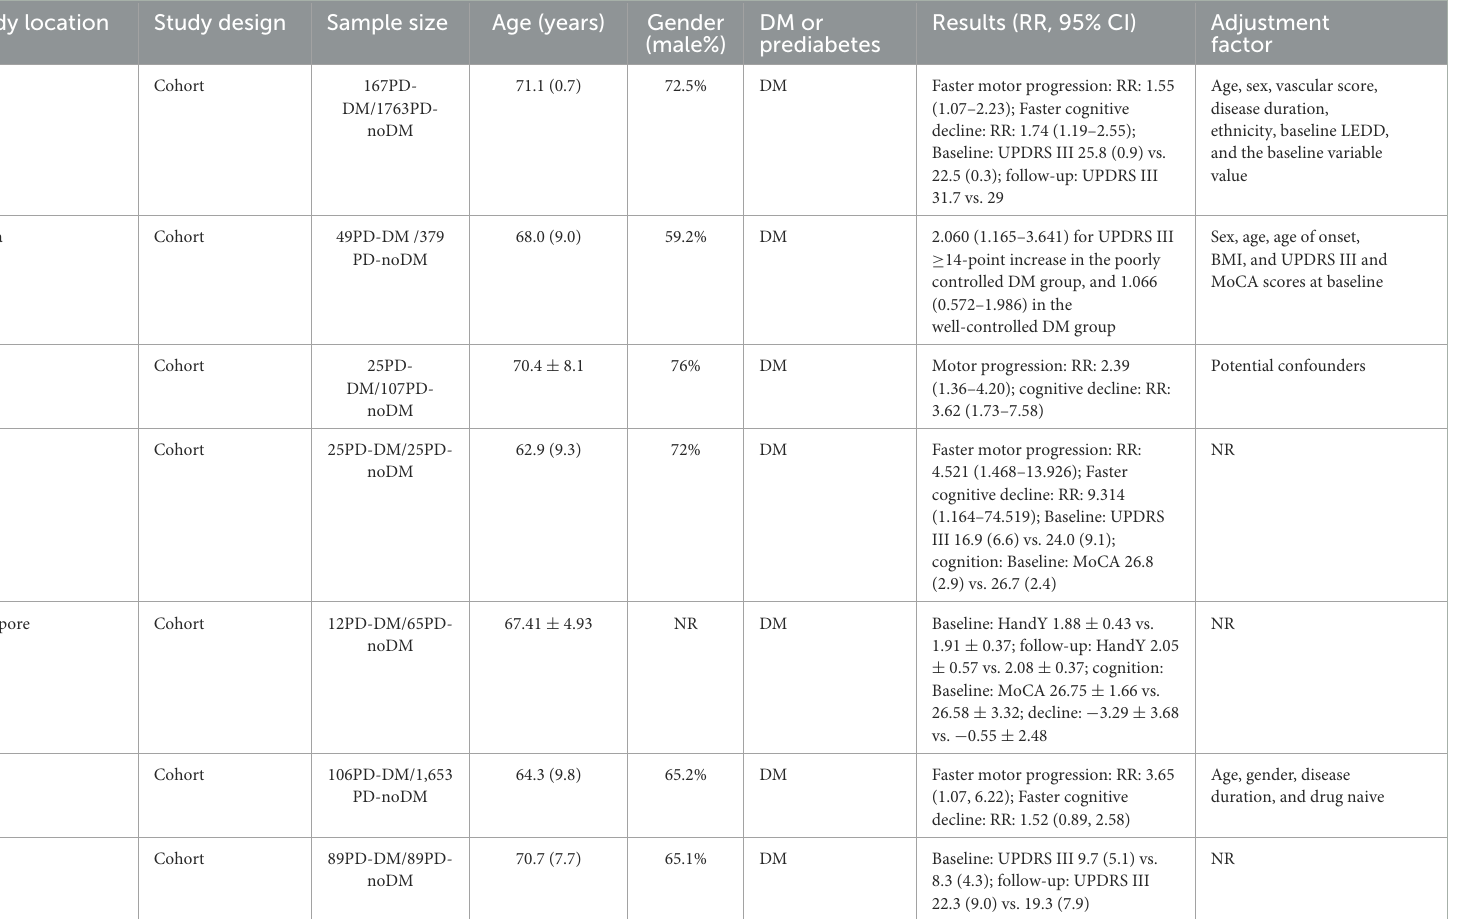
TABLE 2 Characteristics of included studies exploring association between DM and disease progression of